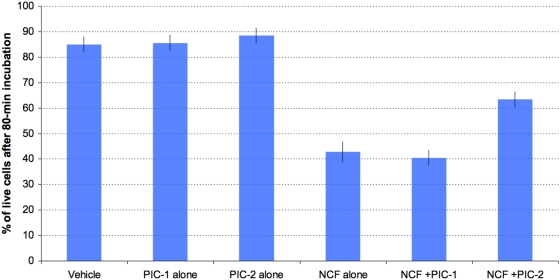
Effect of antiphosphatase incorporation on splenocyte survival upon exposition to the non-cytosolic trypanosome fraction (NCF).Splenocytes were exposed for 80 min to the non-soluble fraction corresponding to 4 108 trypanosome equivalents per ml. Vehicle, PBS ; PIC-1 & -2, phosphatase inhibitor 1 and 2 respectively ; NCF, non-cytosolic trypanosome fraction. Values are means±SD of three independent experiments. Asterisks show values significantly different from T values (P<0.05).